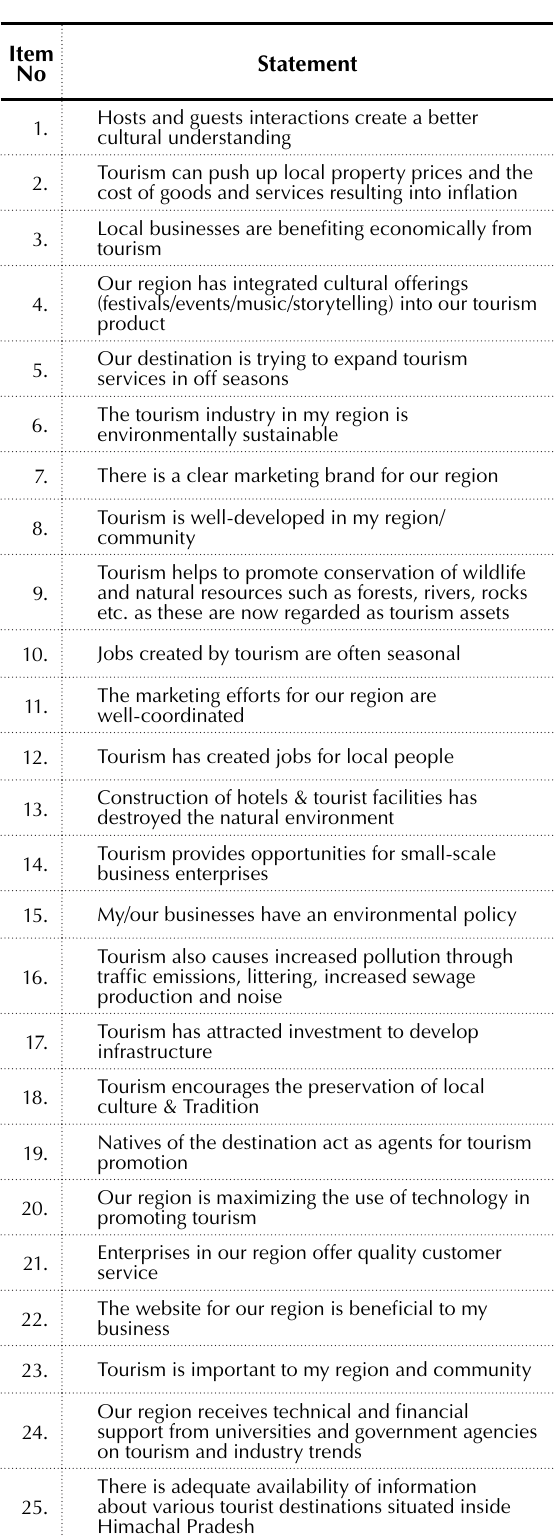
Table 2. Statements of factors, measuring opinions of stakeholders towards